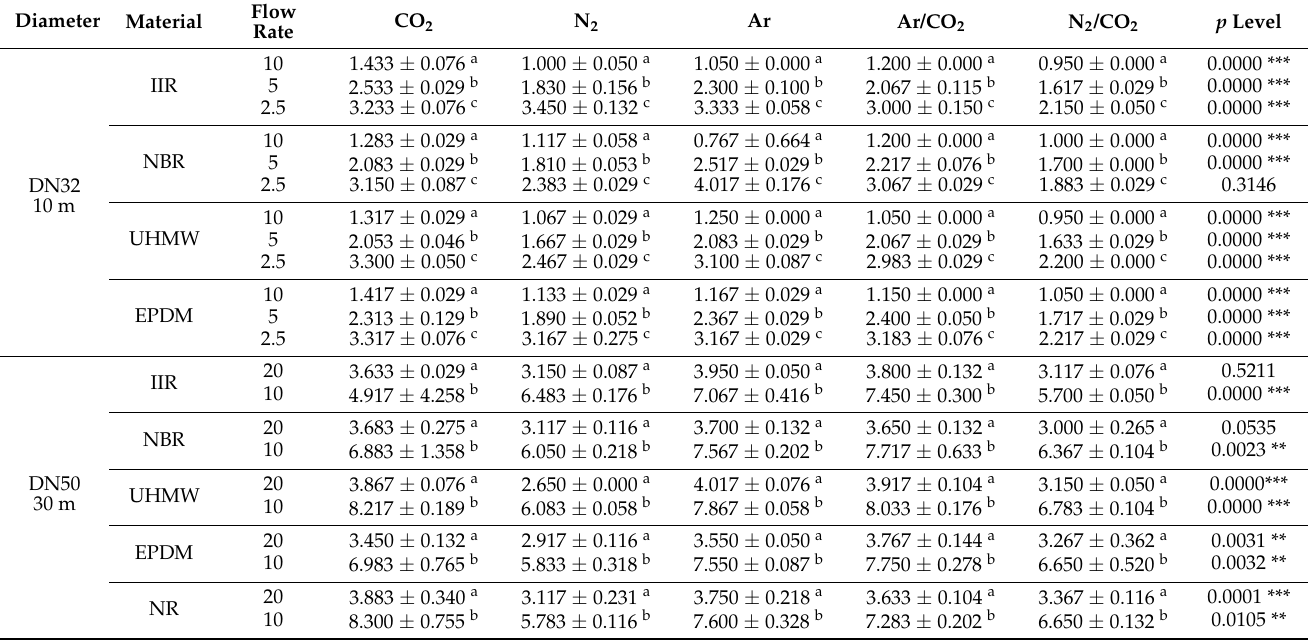
Table 4. Time required (min) to flush the hoses with the different inert gases and flow rates ( n = 3).